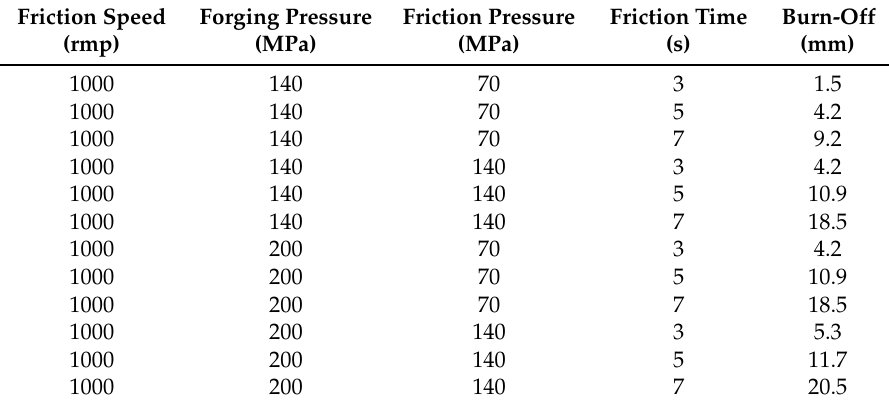
Table 1. Experimental conditions of friction